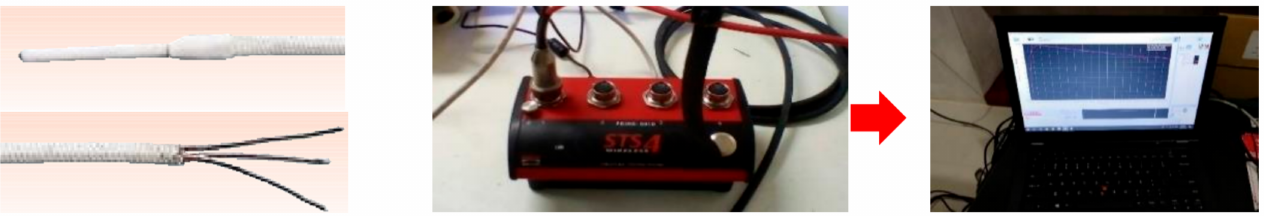
Figure 4. High precision thermal RTD sensor (RTD-1PT100K2515-36-T) and data acquisition